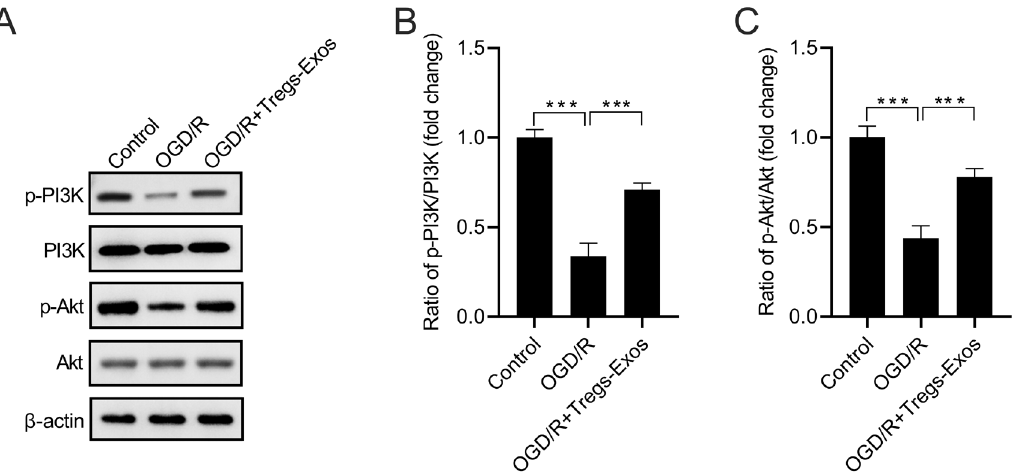
Figure 4 – Tregs-Exos activates the PI3K/Akt signaling in BV-2 microglia under the challenge of OGD/R. (A) Representative images of western blot analysis for PI3K, p-PI3K, Akt, and p-Akt expression. (B-C) Relative ratios of p-PI3K/PI3K and p-Akt/Akt were calculated. *** p <